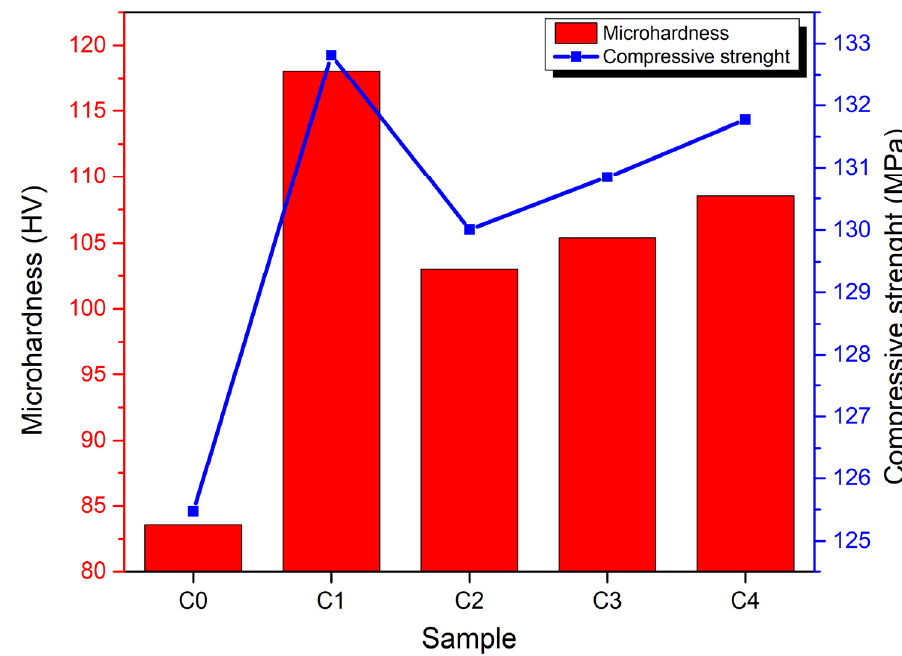
Figure 5. Microhardness and compressive strength of the cast